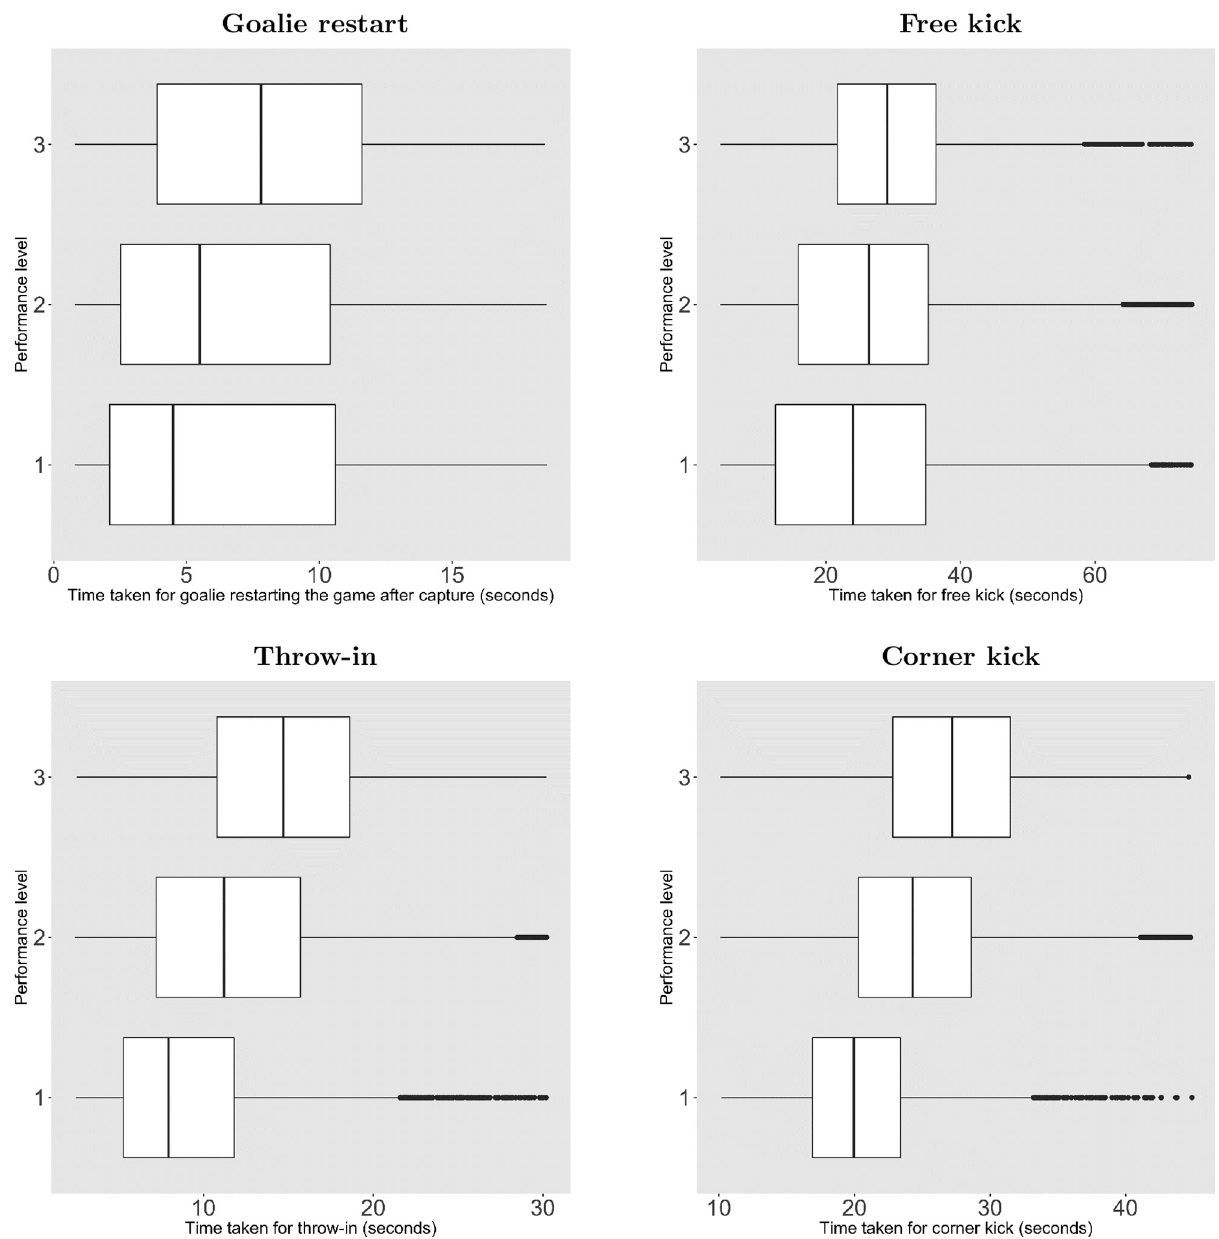
Fig 2. Delay of game as function of performance. Performance level . 1 = Bottom 10% (low performance). 2 = Middle 80%. 3 = Top 10% (high performance). scatterplot of average effective playing time per home game by average points by home game (green triangles) and away game (red circles) with fitted lines. Teams are awarded zero points for a loss, one for a tie, and three for a win. The fitted lines shows greater effective playing time for teams that earn more points per game, as one would expect if time-wasting is a way for weak teams to seek wins against stronger teams. The dispersion of expected effective playing time is signficant, both on an absolute scale and relative to the fitted line. The large effects of time-wasting incentives and the large interteam variation suggests that rule changes that